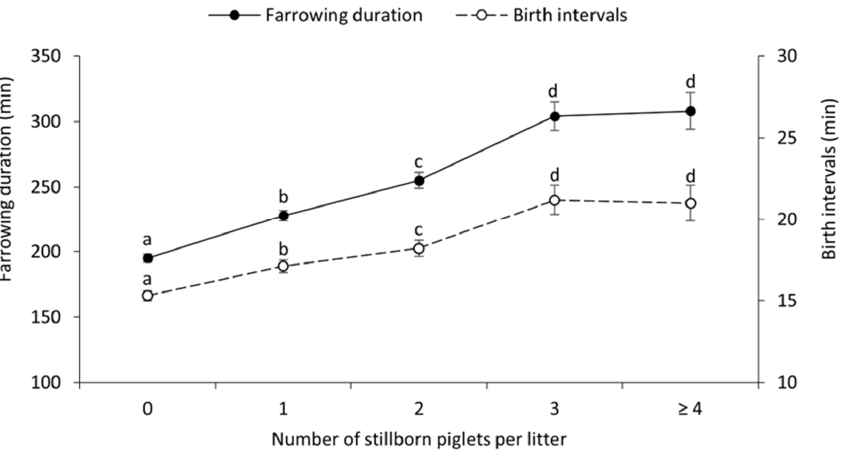
Figure 3. Farrowing duration and birth intervals of sows with different numbers of stillborn piglets per litter. a,b,c,d Different superscripts differ significantly ( p < 0.05).